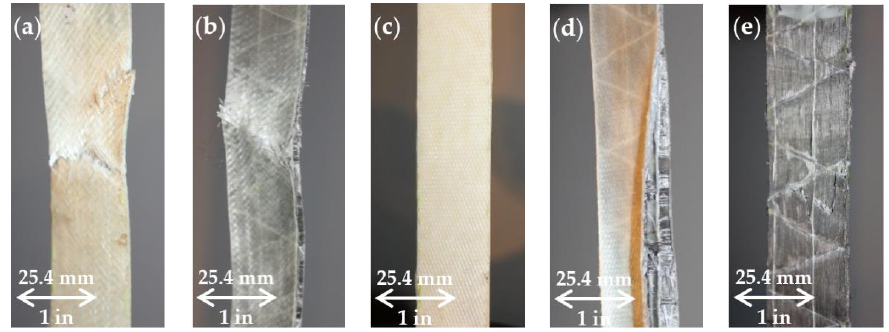
Figure 5. ( a ) E-glass; ( b ) E-glass hybrid; ( c ) S-glass; ( d ) S-glass hybrid and ( e ) Stainless steel composite failure modes.